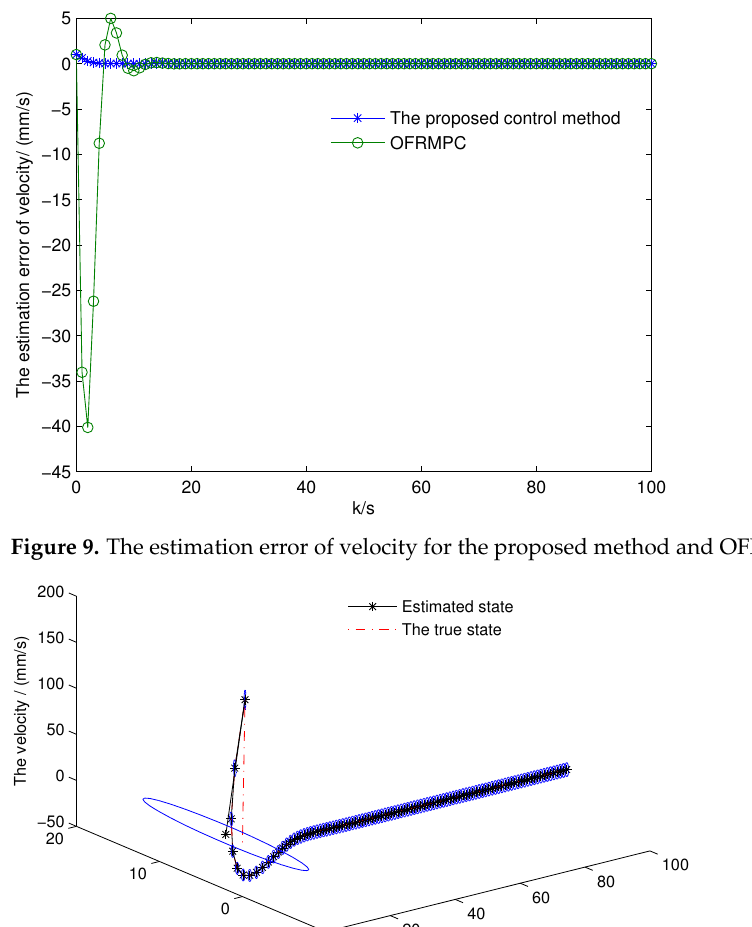
Figure 8. The estimation error of displacement for the proposed method and OFRMPC method.